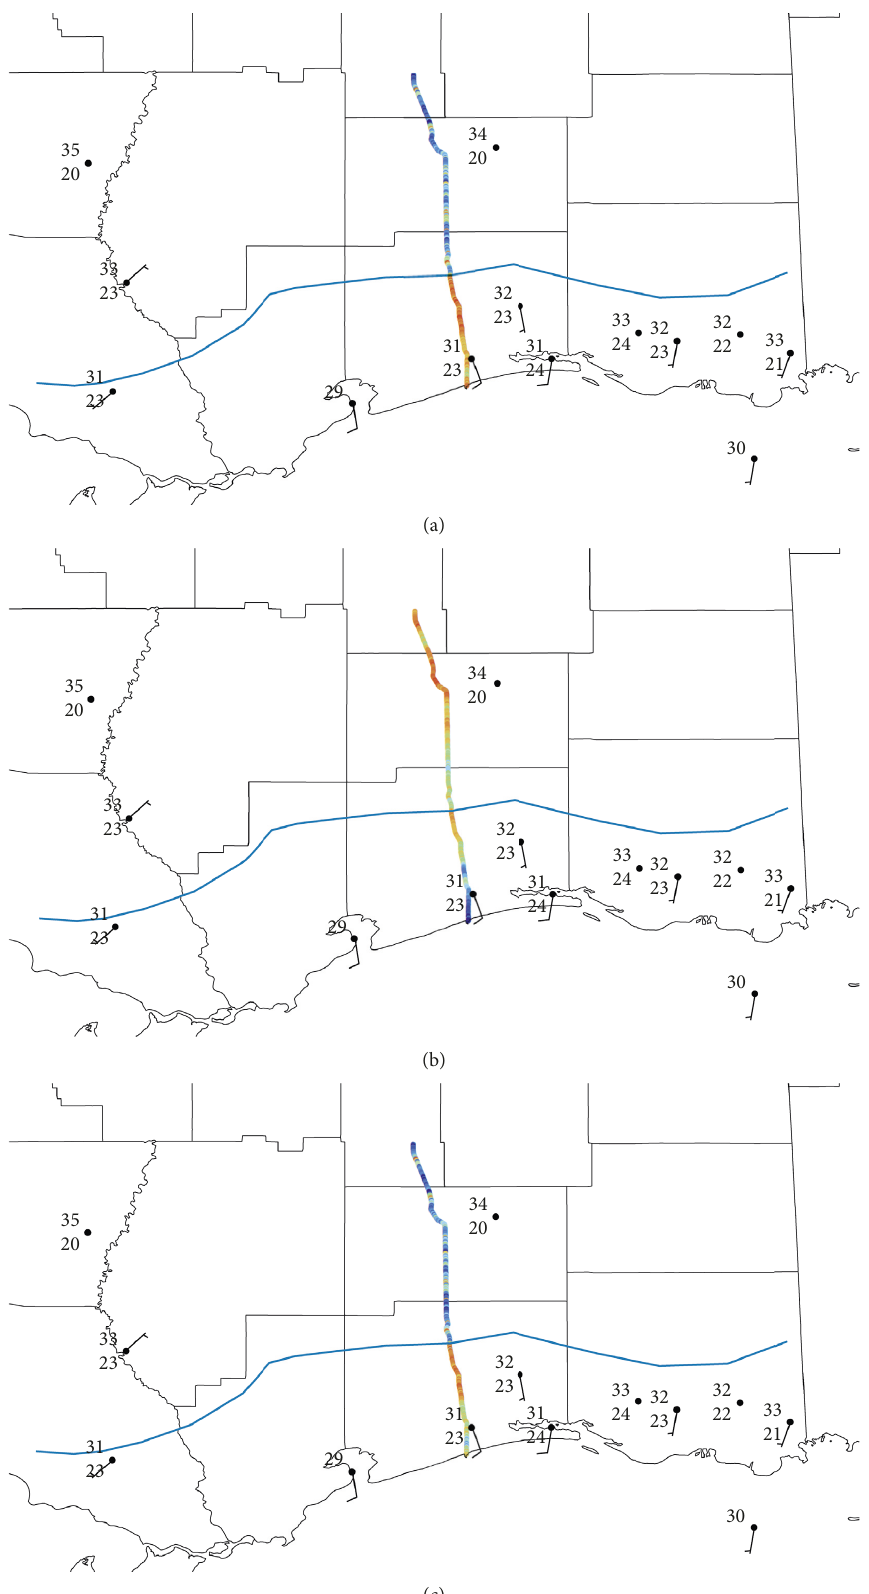
Figure 6: Map views of 5 August 2014 transect data in relation to 2000 UTC (1500 CDT) station observations. Standard station model with temperature and dewpoint in Celsius and wind speed in kt. Wind barbs are in kt. Blue line delineates position of the SBF determined from radar. All transect data are scaled with highest values in red and lowest values in blue. (a) Mixing ratio. (b) Virtual potential temperature. (c) Equivalent potential